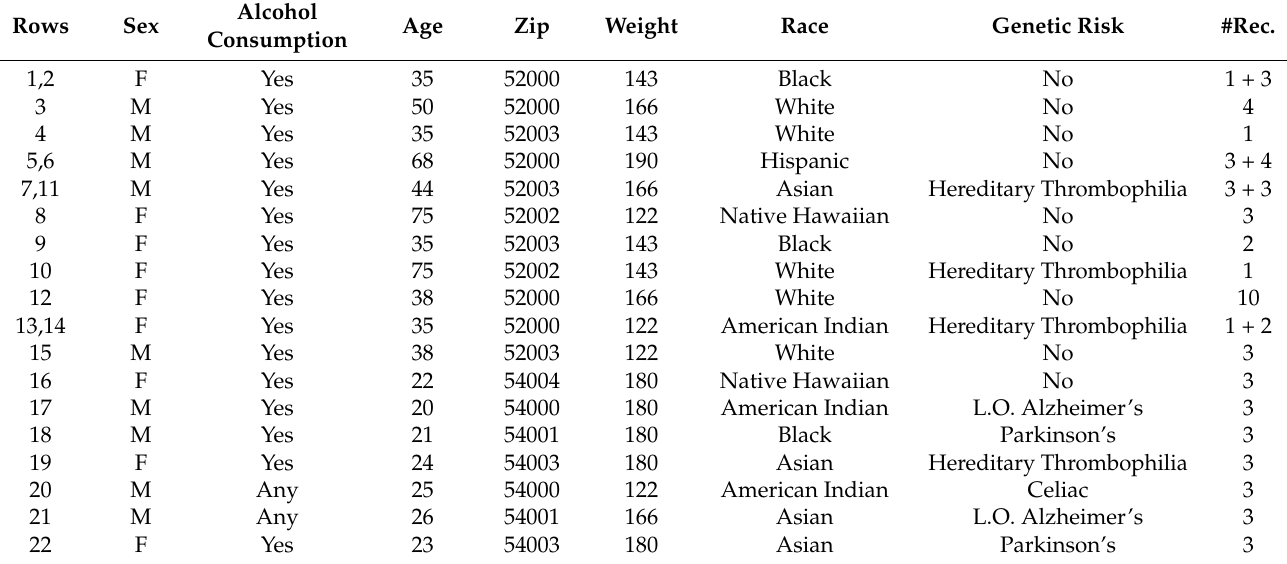
Table 6. Resultant table from Greedy